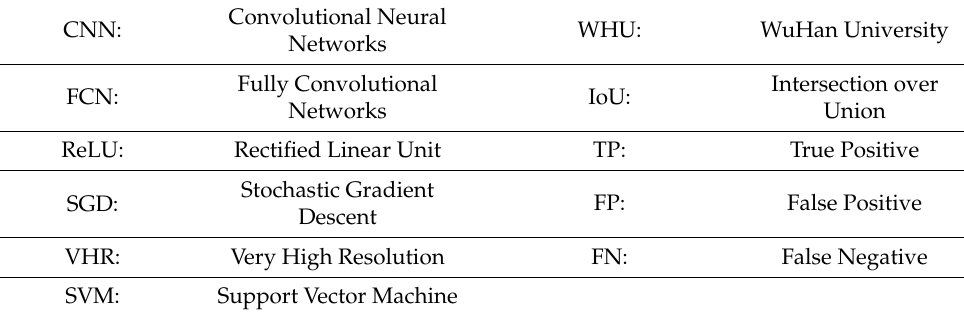
Table 3. The major abbreviations used in our paper.